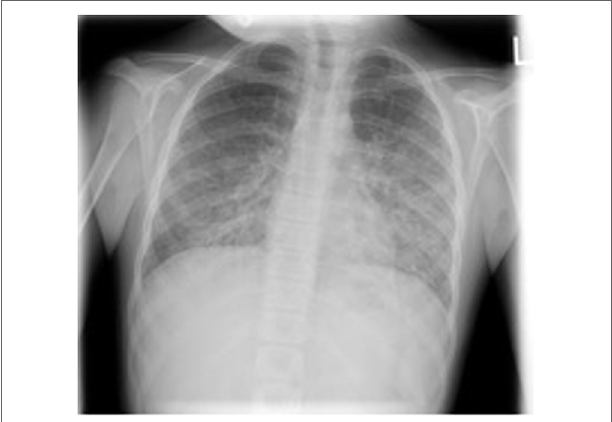
FIgURe 1 | Chest X-ray demonstrating bilateral pulmonary infiltrates caused by pneumocystis